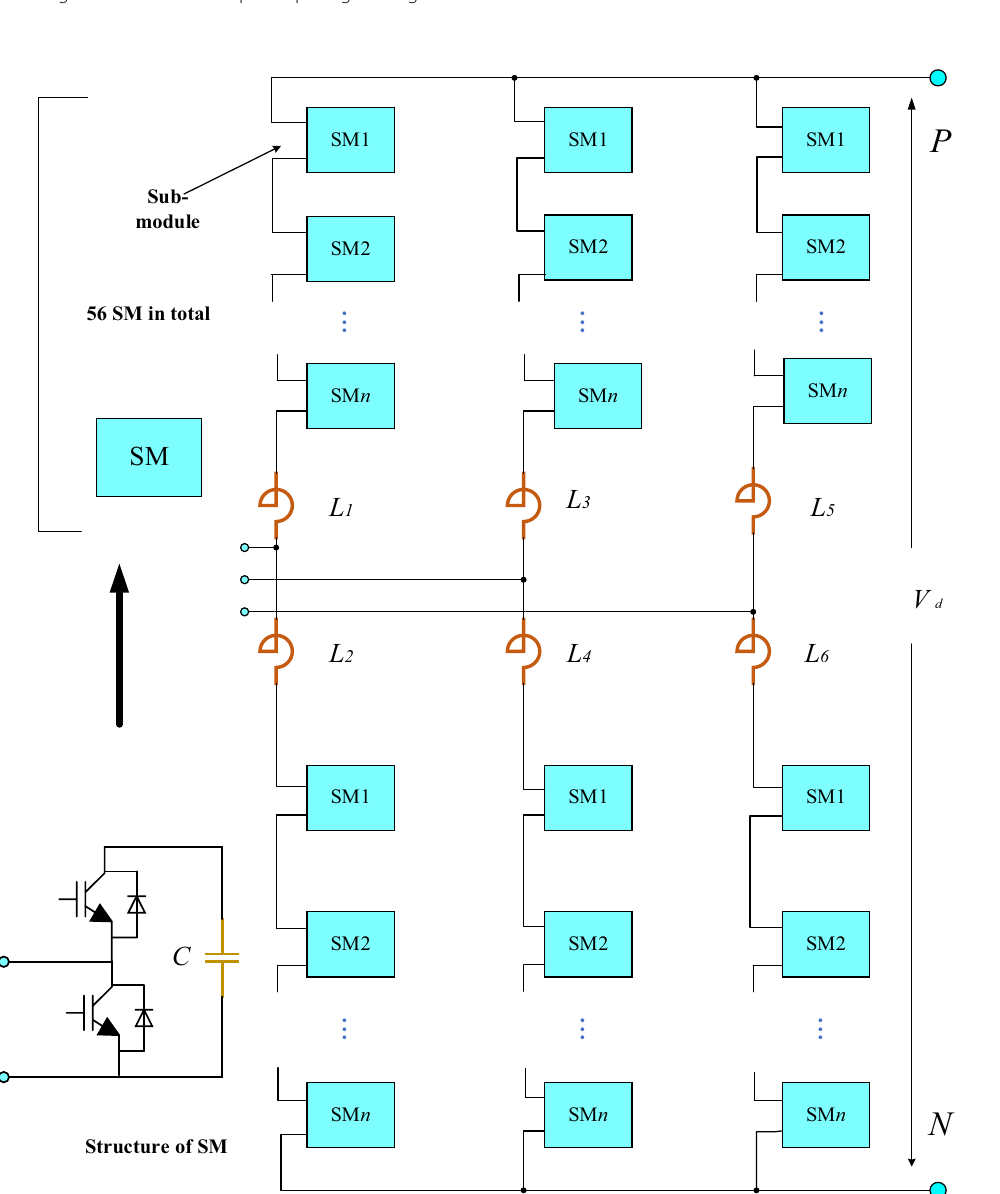
Fig. 9 Structure of three-phase VSC based on modular multilevel